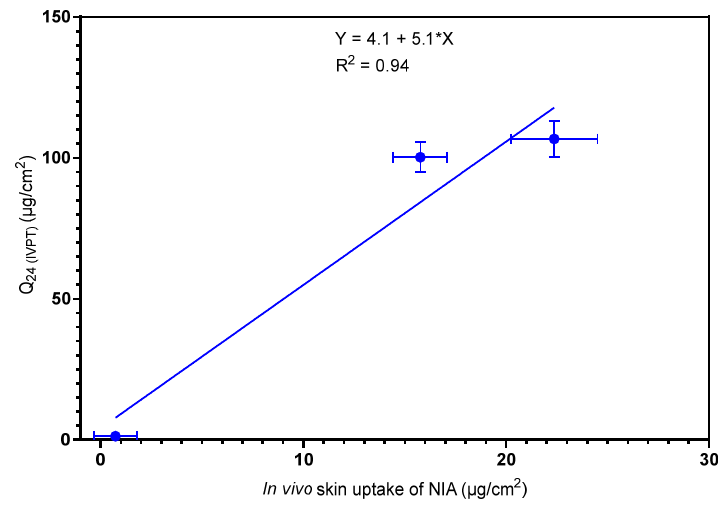
Figure 6. Correlation of the in vitro cumulative amount of NIA permeated after 24 h (4 ≥ n ≥ 3; mean ± SEM) and the total amount of NIA in the SC per skin surface area after 60 min in vivo ( n = 8; mean ± SEM).